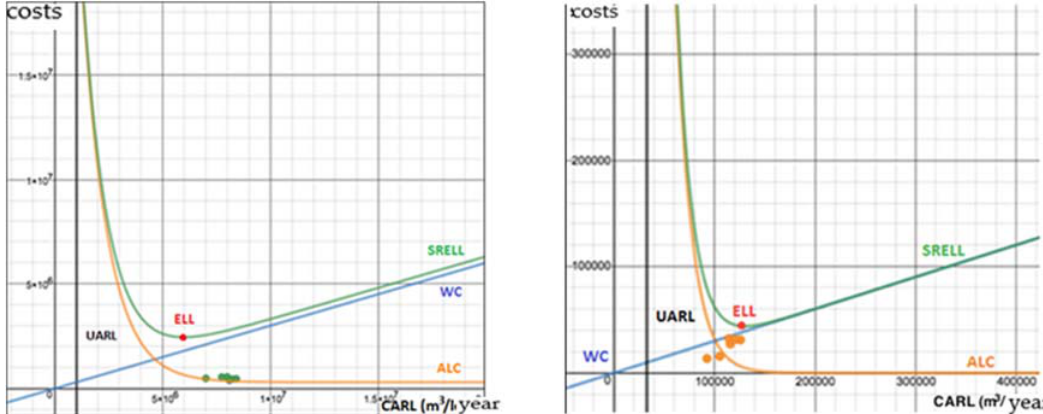
Figure 2. Parameters of short term economic losses in VO ‐ KA company (central system in left, Pijava Gorica in the right picture). Source: Calculation based on company’s